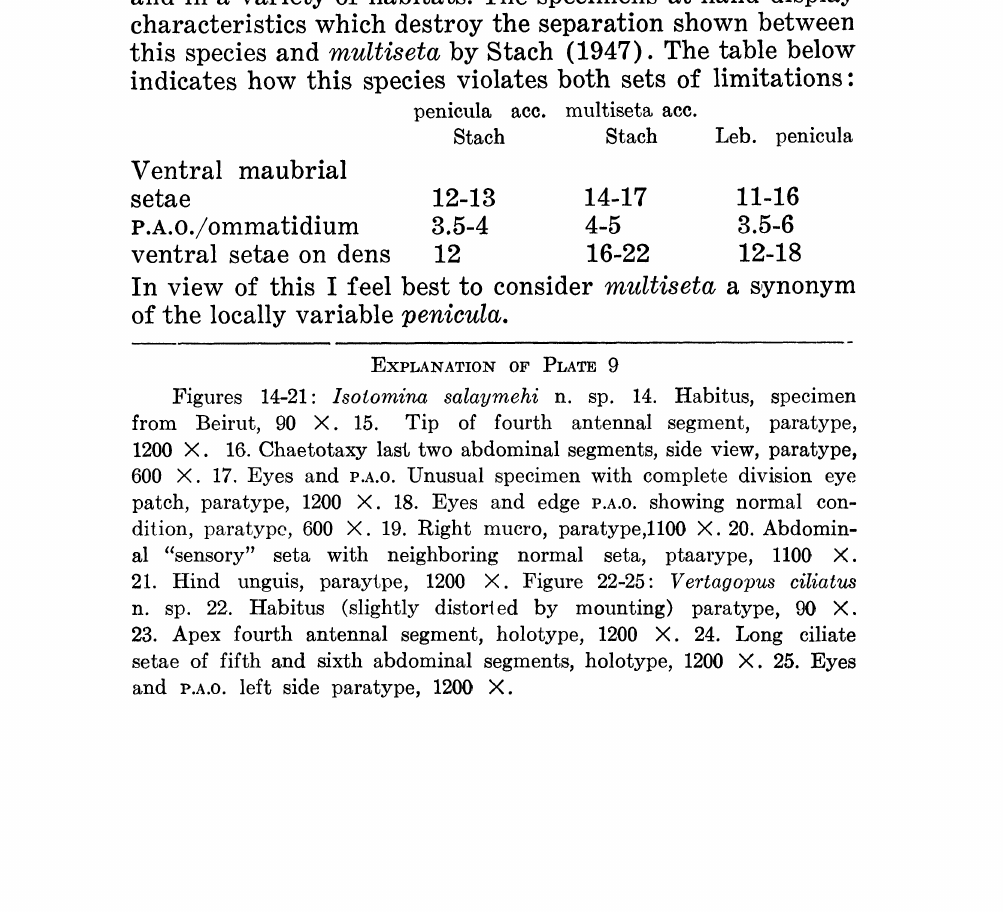
Figure 22-25: Vertagopus